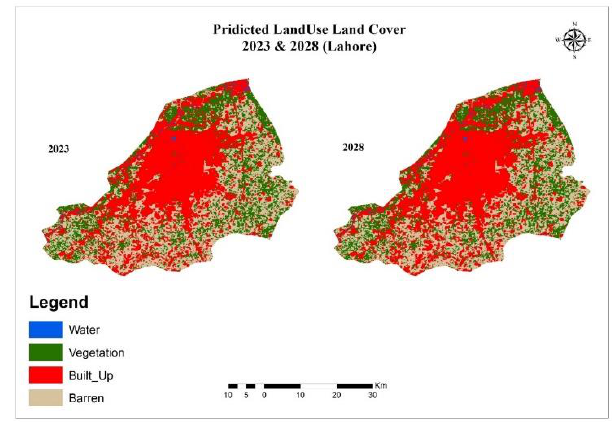
Figure 5: Predicated LULC of Lahore for 2023 and